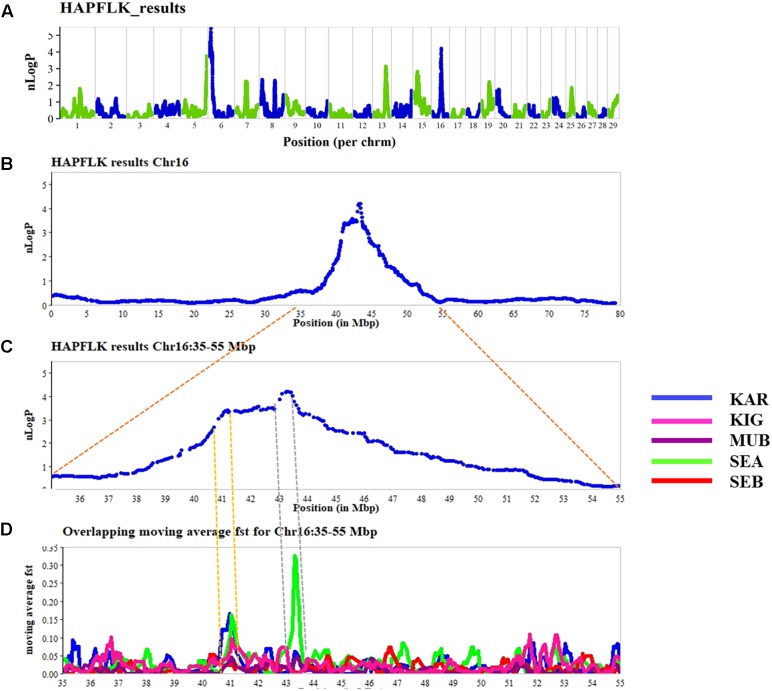
Genome-wide scan for putative signatures of selection using the hapFLK (A). The negative log of p-values is plotted in chromosomal order. The alternating colors green and blue represent the different chromosomes (on the upper panel). On the lower panels, (B–D) is a zoom into the chromosome 16 to show the regions overlapping with high FST and hapFLK values, defining putative selection signatures over four selected regions in the different breeds (KAR = Karamojong, KIG = Kigezi, MUB = Mubende, SEA = Small East African, and SEB = Sebei).